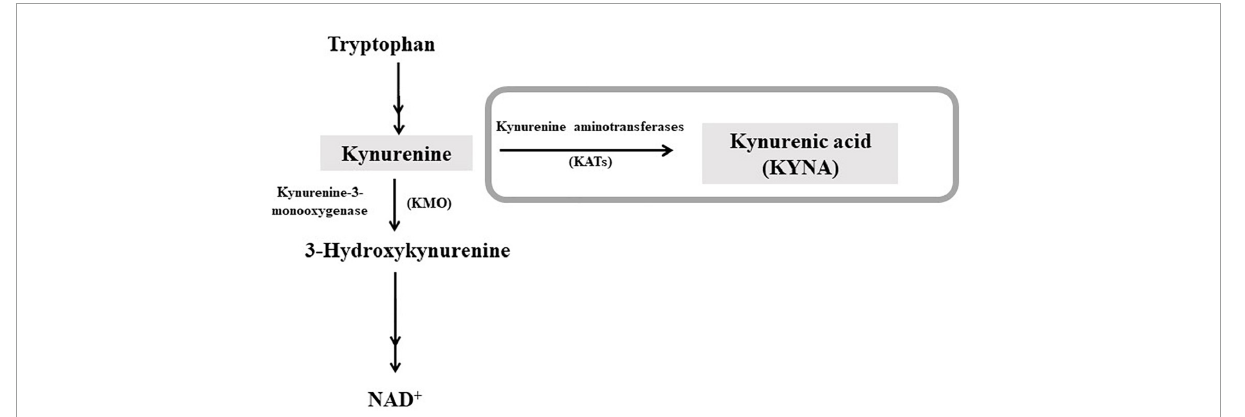
FIGURE1 Schematic representation of the kynurenine pathway of tryptophan degradation. Kynurenic acid (KYNA) is synthesized from kynurenine by kynurenine aminotransferases (KATs). In the second ramification of the kynurenine pathway, kynurenine is metabolized by kynurenine 3-monooxygenase (KMO), leading to NAD + as final product. For a complete representation of the pathway, see Schwarcz et al.